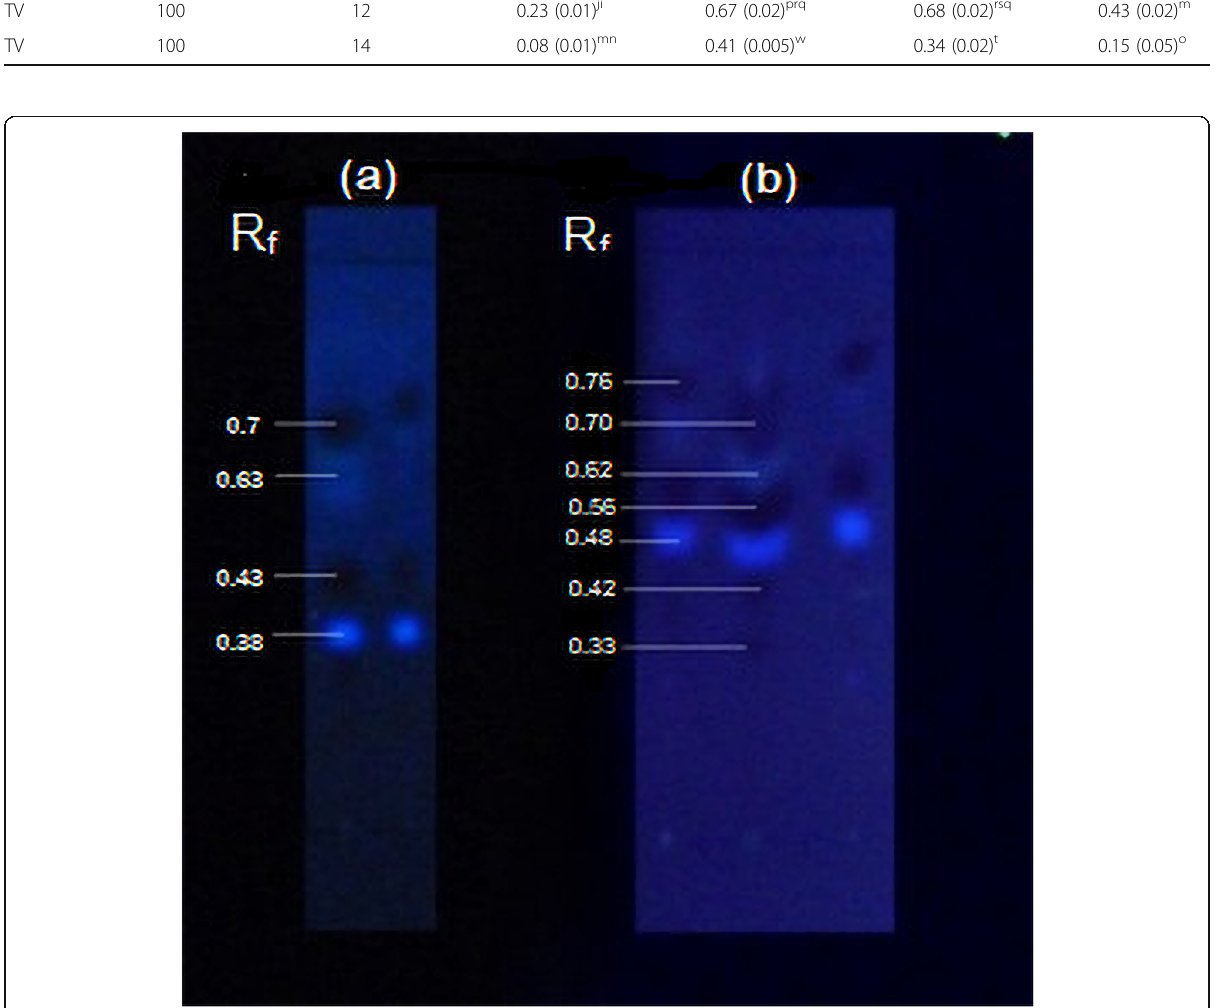
Fig. 11 TLC profiles of biologically elicited G. walla cell suspension ( a ) L. theobromae (1) 8 mg/L, (2) 10 mg/L and ( b ) P. parasitica (1) 6 mg/L, (2) 8 mg/L, (3) 10 mg/L on the 6 th